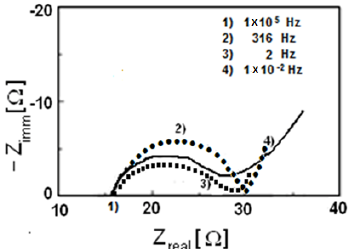
Figure 13. Impedance spectroscopy of: ( a ) • LiMn 0.1 Fe 0.9 PO 4 ; ( b ) − LiMn 0.05 Fe 0.95 PO 4 ; and ( c ) ▪ LiFePO 4 .